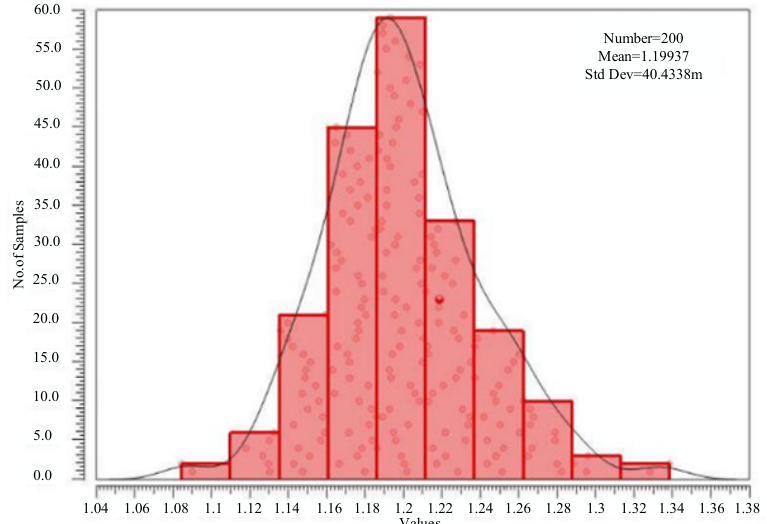
Figure 9. The results of the Monte Carlo simulation of the proposed BGR circuit.